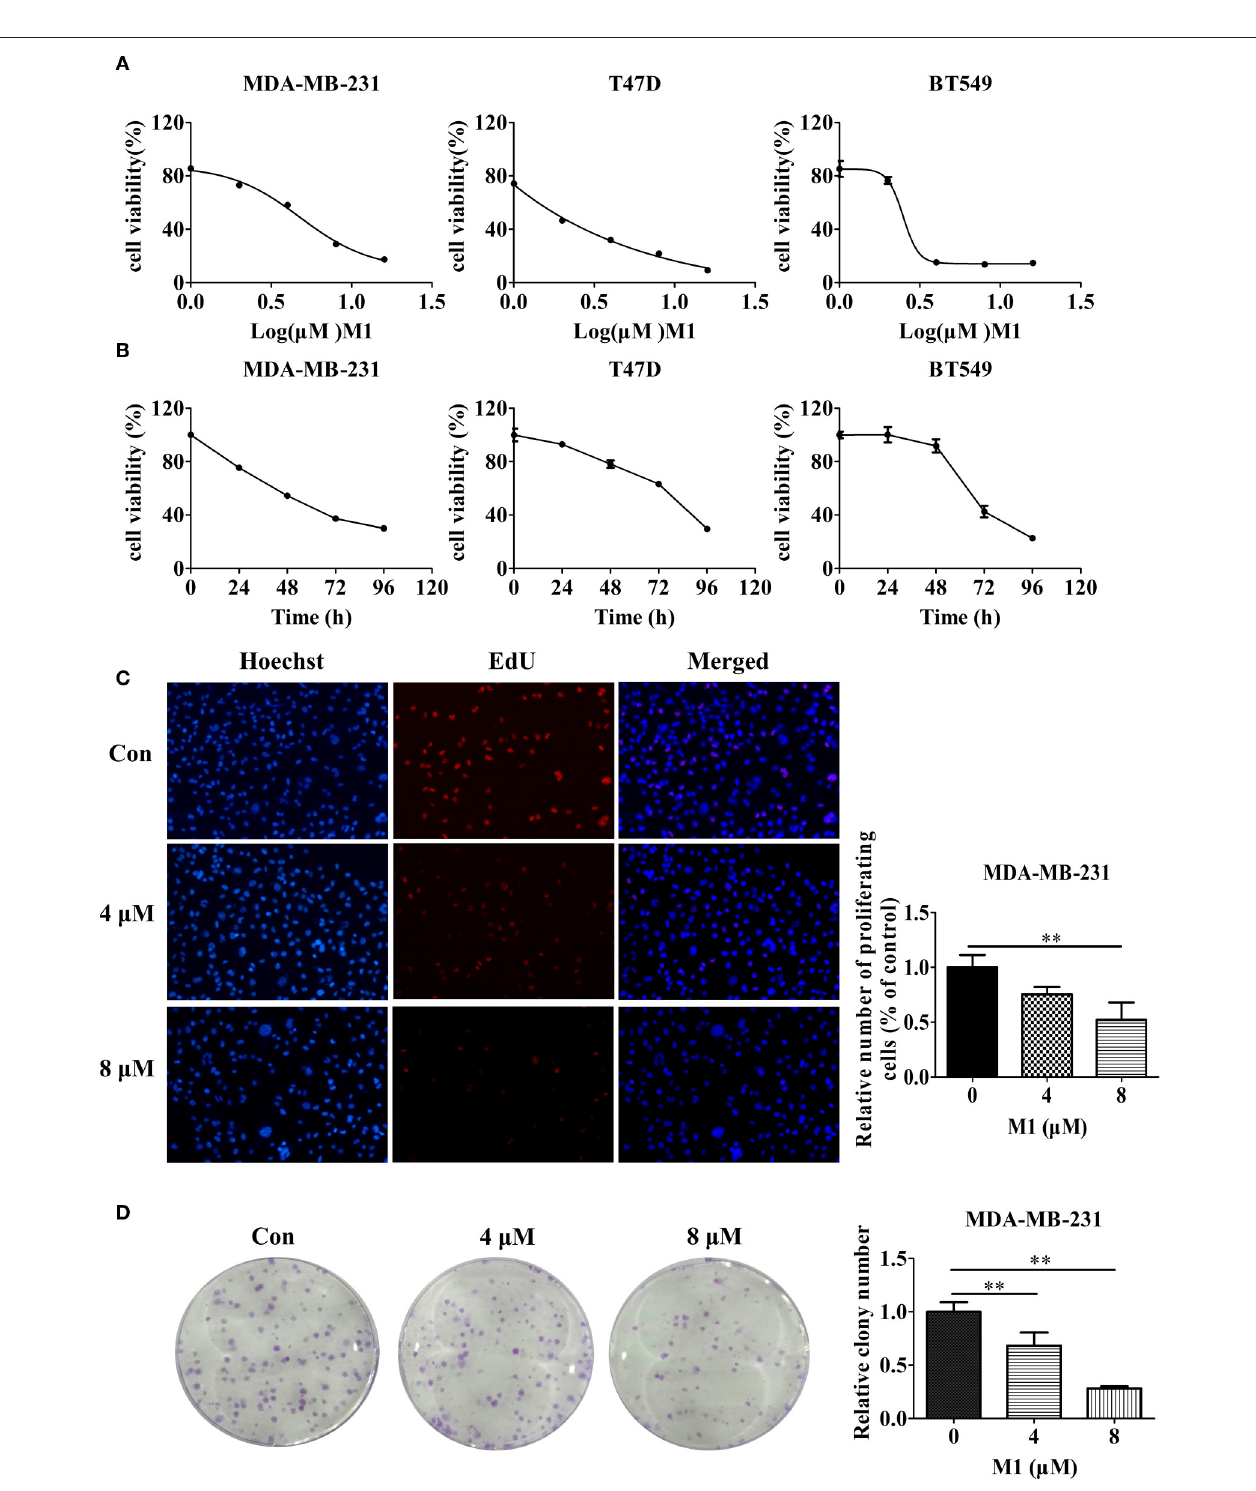
FIGURE 7 | Compound M1 inhibits cell proliferation in breast cancer cells. (A) MDA-MB-231, T47D, and BT549 cells were treated with a series of doses of compound M1 for 72h. (B) MDA-MB-231, T47D, or BT549 cells were treated with 5, 2, or 3 µ M compound M1 for difference time periods. After treatment, cell viability was estimated by CCK-8 assay. Compound M1 vs. control, * p < 0.05, ** p < 0.01, student t- test, n = 3, means ± SD. (C) MDA-MB-231 cells were treated with 4 or 8 µ M compound M1 for 48h. The EdU-marked replicating cells were observed by fluorescent microscope. Compound M1 vs. control, * p < 0.05, ** p < 0.01, student t- test, n = 3, means ± SE. (D) MDA-MB-231 cells were treated with 4 or 8 µ M compound M1 for 48h, and the cell colonies were fixed and stained for camerawork. Compound M1 vs. control, * p < 0.05, ** p < 0.01, student t- test, n = 3, means ± SE.